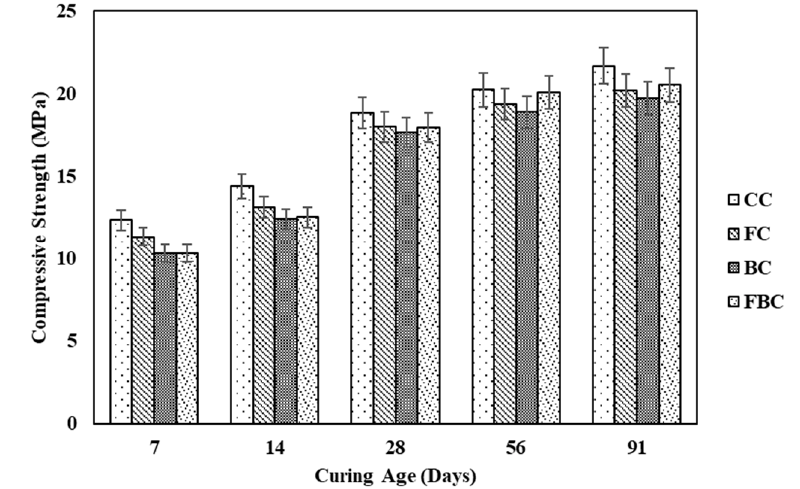
Figure 3. Compressive strength of mass concrete samples containing FA and BT.